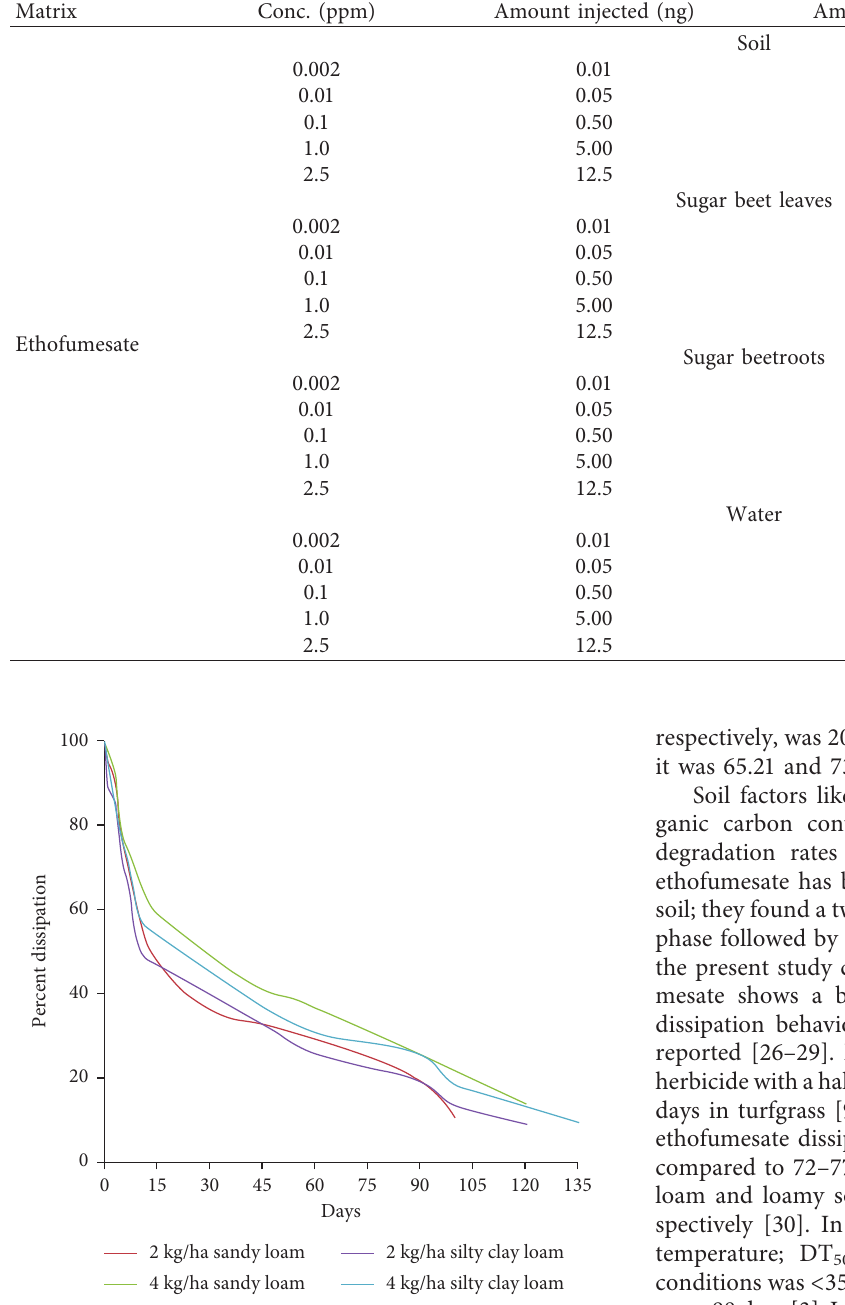
Figure 1: Dissipation of ethofumesate in